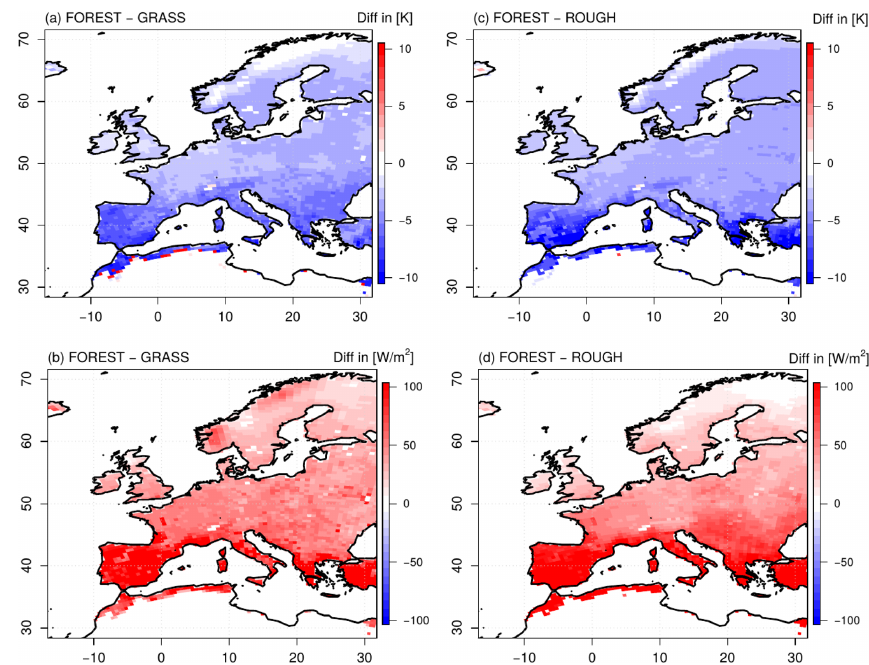
Figure 6. Differences in mean seasonal daily maximum surface (top of vegetation) temperature (a, c) and seasonal sensible heat fluxes (b, d) in summer between the FOREST and the GRASS experiments (a–b) and the FOREST and the ROUGH experiments (c–d) over the simulation period